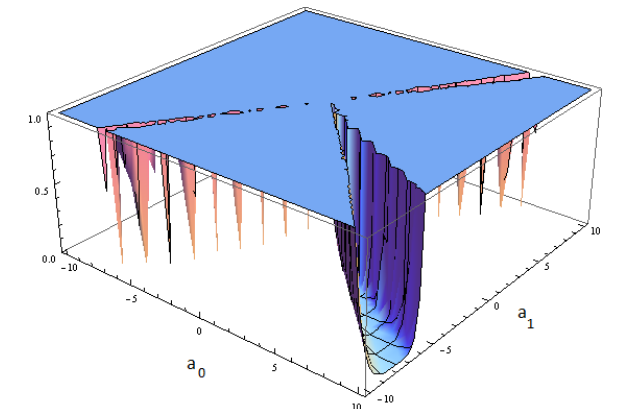
Figure 3. Stability region of ex 2 ( a 0 , a 1 )